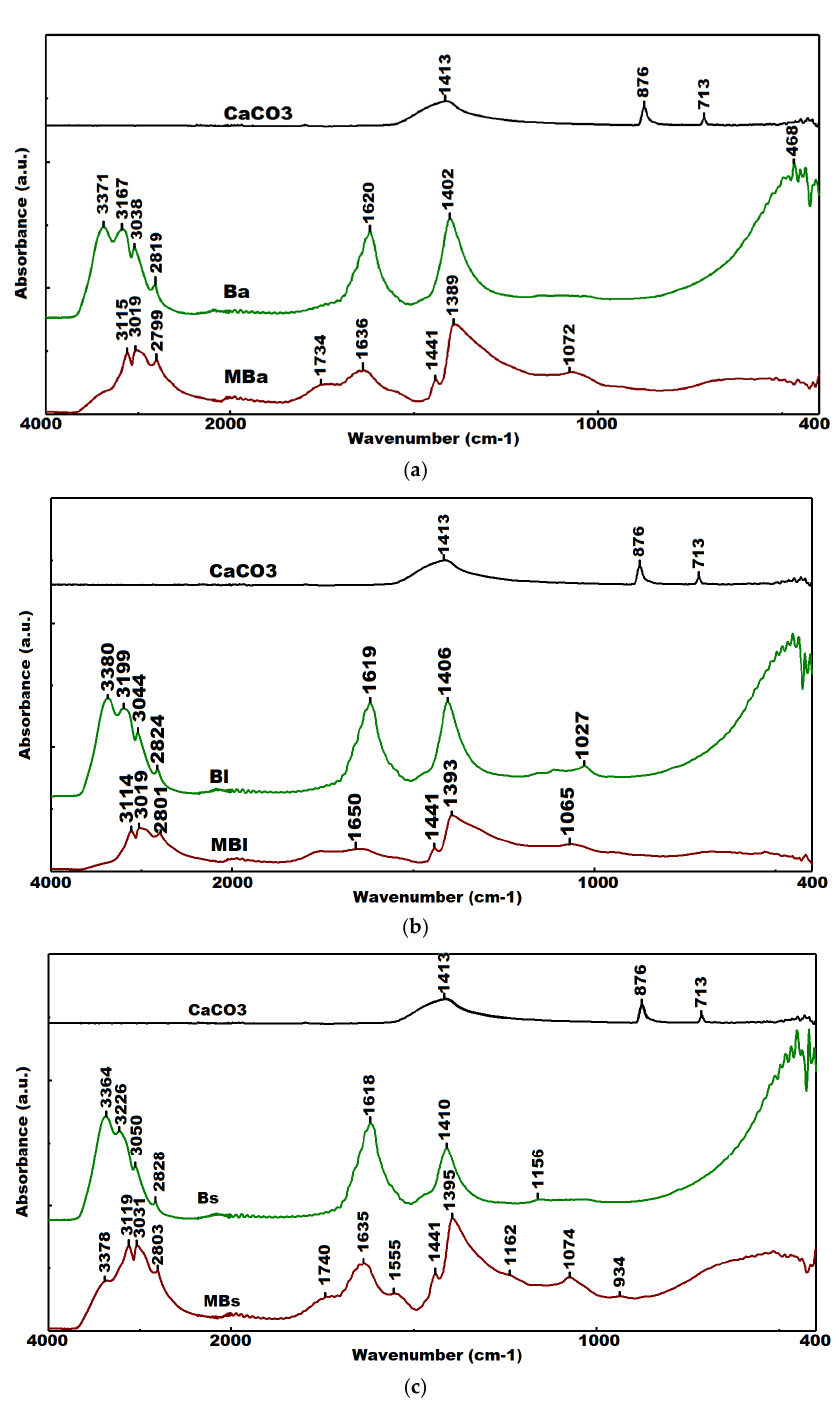
Figure 6. Overlaps of FTIR spectra of bacterial deposits from cultures on media with or without urea and calcium ions: ( a ) Bacillus amyloliquefaciens ( b ) Bacillus licheniformis ; ( c ) Bacillus subtilis . In our experimental study, a broad vibrational band corresponding to the O ‐ H stretch of the carboxyl group at 2700–3300 cm − 1 was identified for all samples. However, at the same time, within this domain, it is possible to have a band assignment to NH 2 stretching in adenine, cytosine or guanine [48]. In addition, we have detected a vibrational band